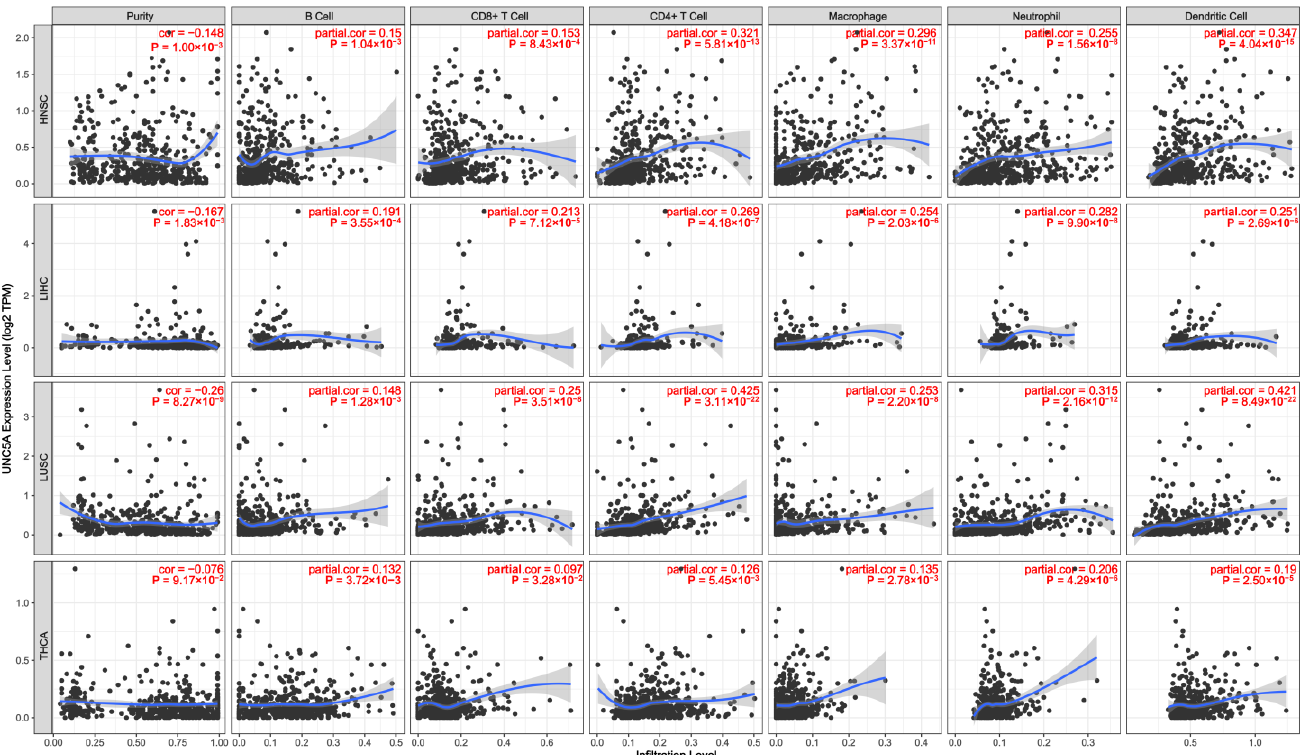
Figure 9. Correlation analysis between UNC5A expression and immune infiltration levels of B cells, CD8+ T cells, CD4+ T cells, macrophages, neutrophils, and dendritic cells in pan-cancer.